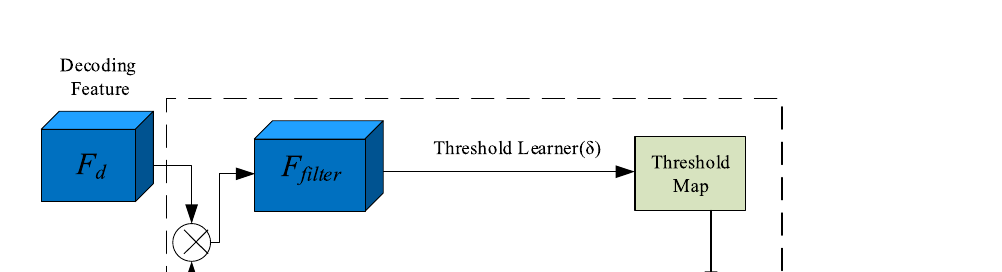
Figure 2. The architecture of standard transformer.